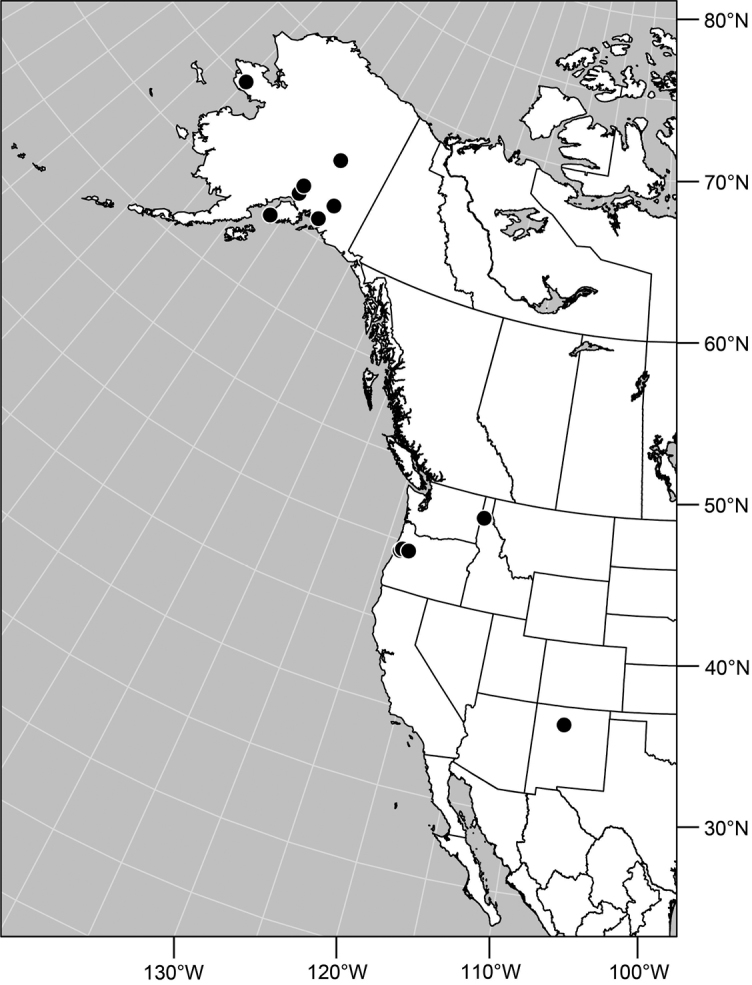
Distribution of Polytrichophora salix sp. n.